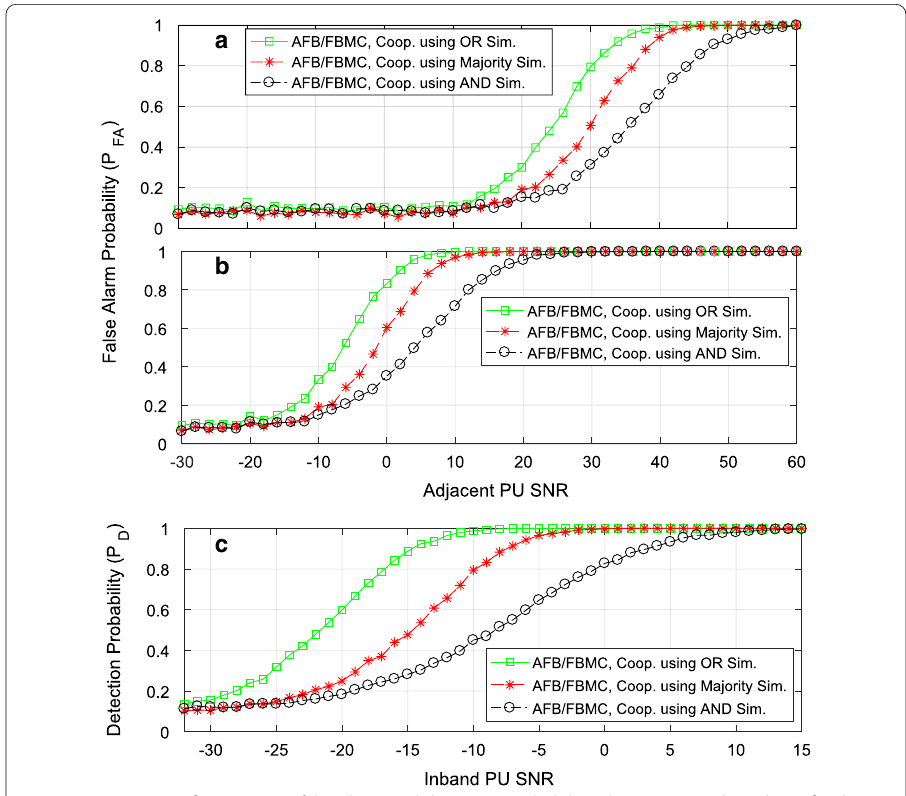
Fig. 6 Comparison of cooperative false alarm and detection probabilities between AFB-based SED for three different linear fusion rules under Indoor channel and log-normal fading ( σ = 9dB ), time record length of N t = 91 , and M 8 sensing stations. a P FA with linear PA. b P FA with nonlinear PA. c P D for inband PU =